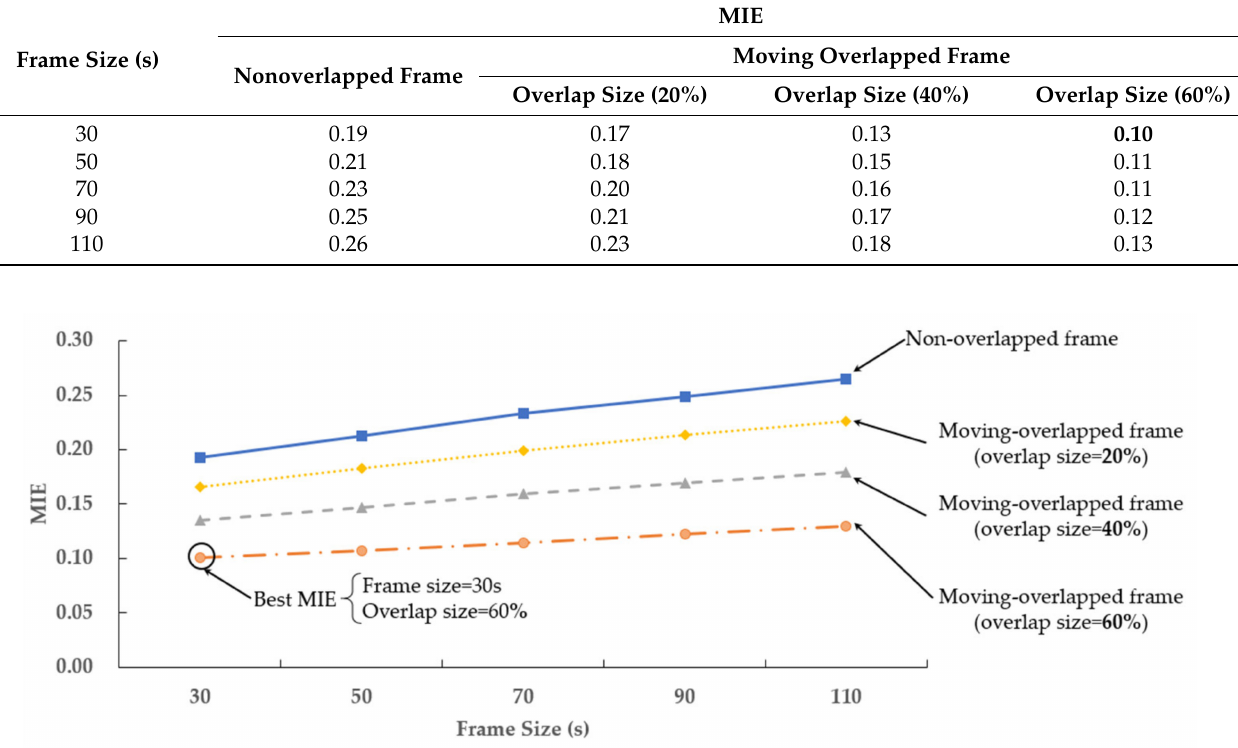
Table 3. Mean interval error (MIE) for different framing methods.